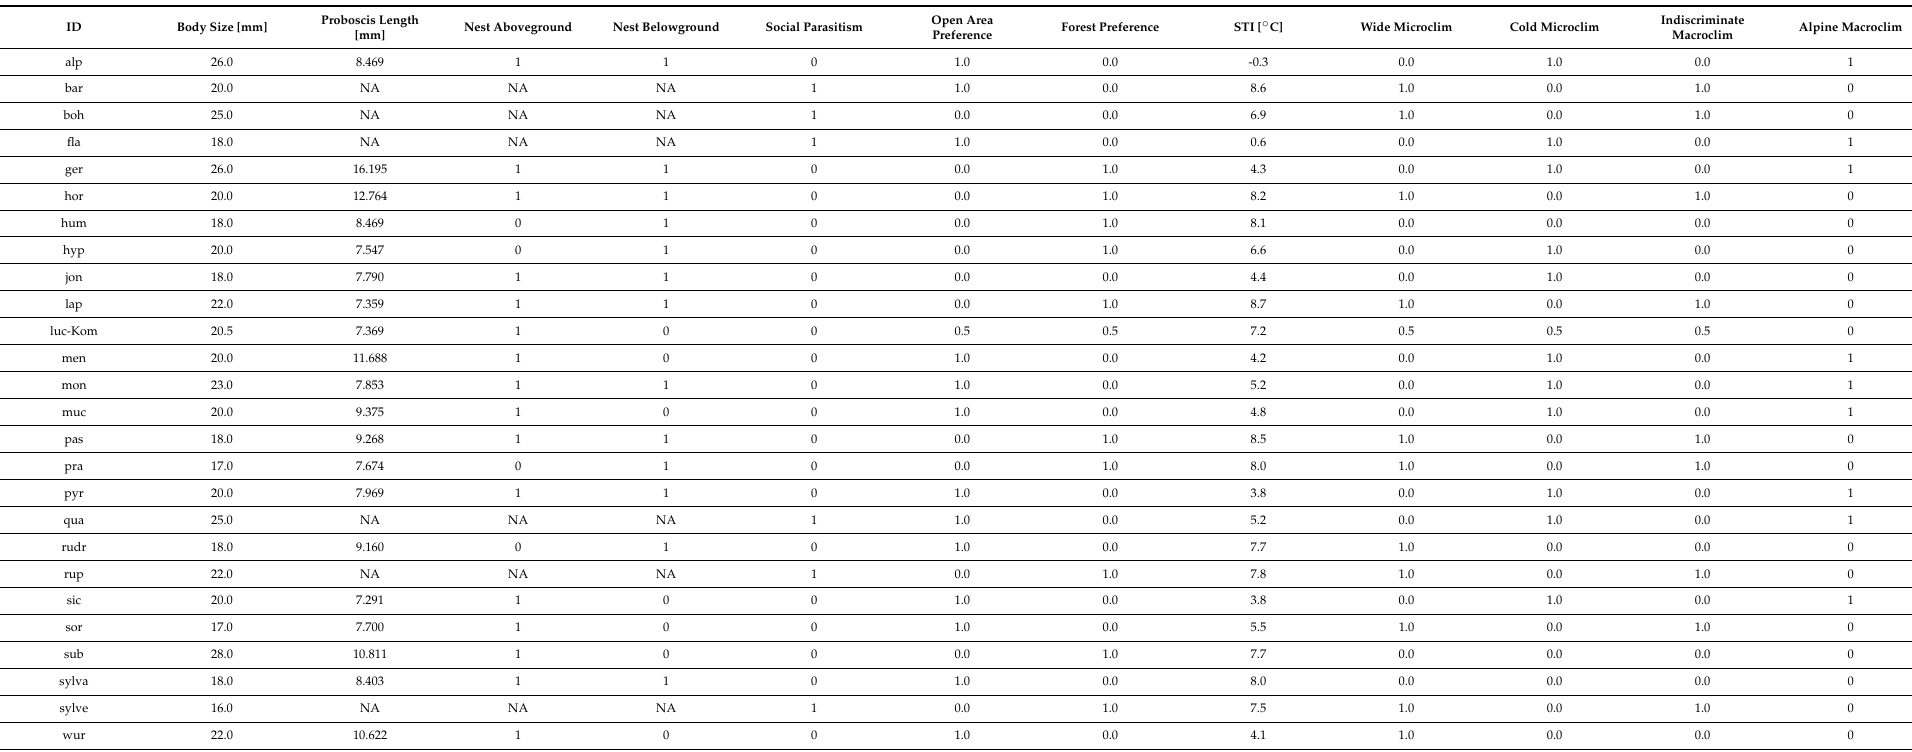
Table A1. Bumblebee species traits. Trait values were taken from recent literature on bumblebee ecology [21,57–59] and the expert assessment of Johann Neumayer. Nesting traits and proboscis length are indicated with NA for socio-parasitic species. The species B. lucorum and B. cryptarum are assigned to the Bombus lucorum/cryptarum complex because these species could not be distinguished with certainty in the 1930s and trait values were averaged between the two species. Trait abbreviations are explained in Table A2. Species abbreviations are as follows: alp = B. alpinus , bar = B. barbutellus , boh = B. bohemicus , fla = B. flavidus , ger = B. gerstaeckerii , hor = B. hortorum , hum = B. humilis , hyp = B. hypnorum , jon = B. jonellus , lap = B. lapidarius , luc-Kom = B. lucorum/cryptarum complex, men = B. mendax , mon = B. monticola , muc = B. mucidus , pas = B. pascuorum , pra = B. pratorum , pyr = B. pyrenaeus , qua = B. quadricolor , rudr = B. ruderarius , rup = B. rupestris , sic = B. sichelii , sor = B. soroeensis , sub = B. subterraneus , sylva = B. sylvarum , sylve = B. sylvestris , wur = B. wurflenii